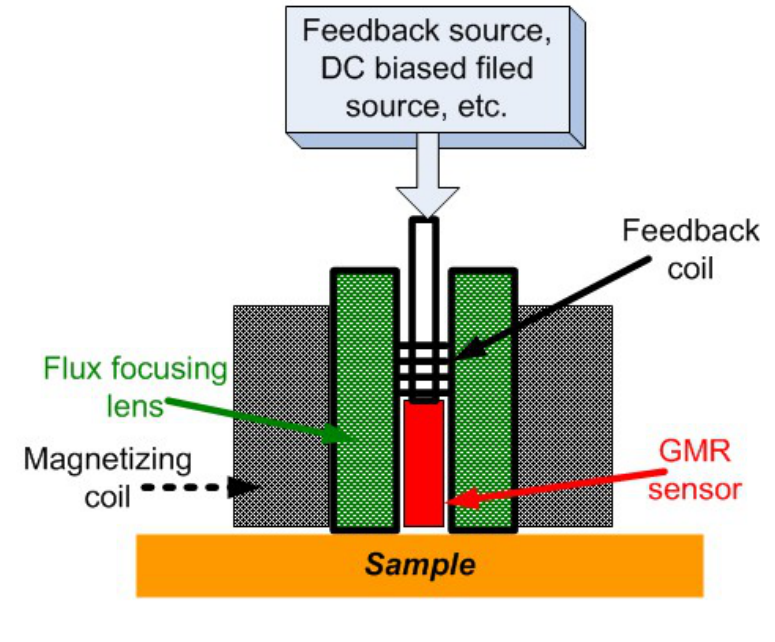
Figure 27. Schematic of SV-GMR based ECT